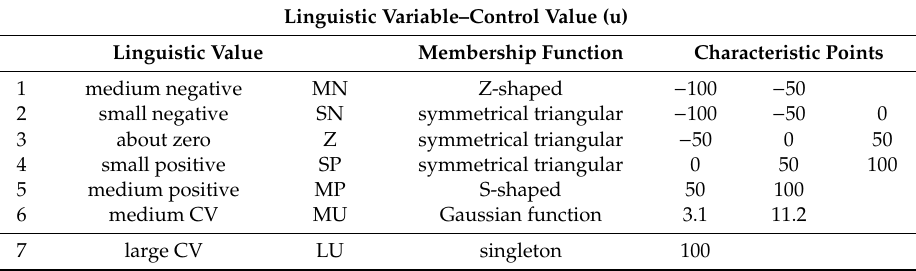
Table 11. The third version of the controller–error derivative. Table 13. The third version of the controller–control value.